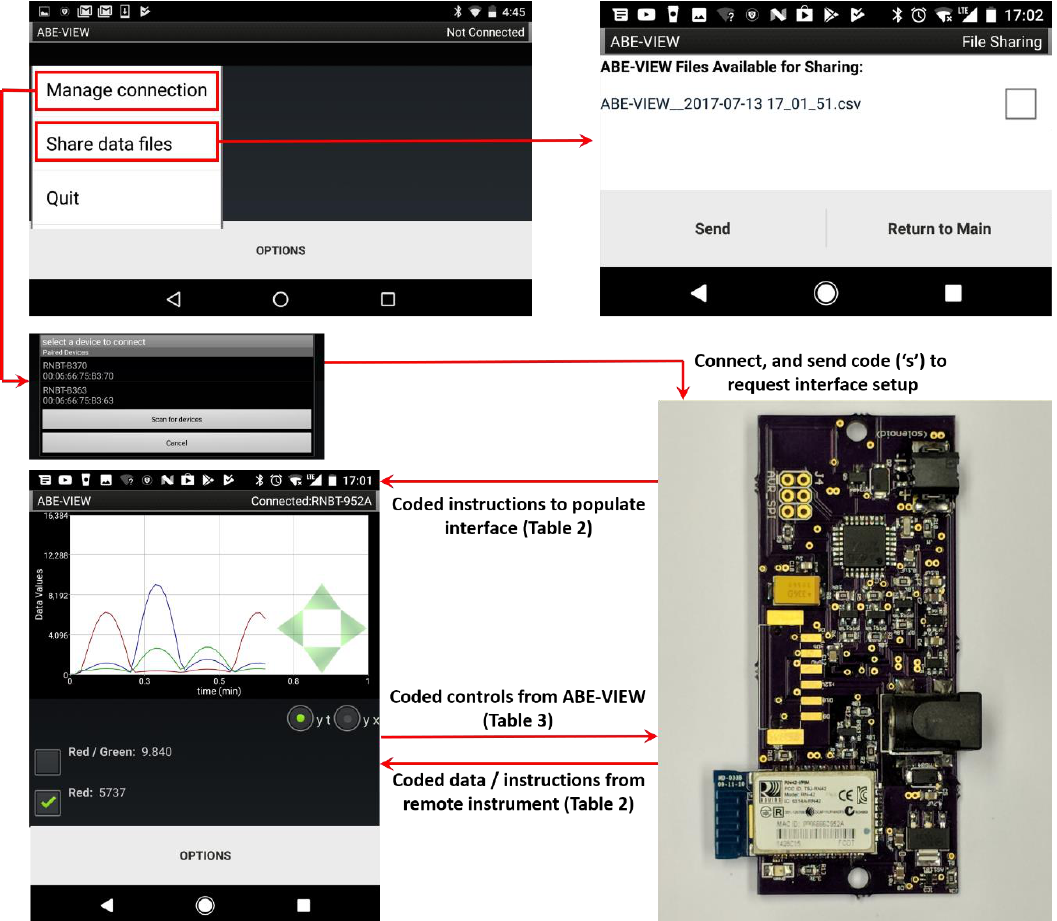
Figure 3. Flowchart for (Bluetooth) communications between ABE-VIEW and remote instrument/device. Upon making a Bluetooth connection with the remote device, ABE-VIEW sends a code ‘s’ that prompts the latter to return coded instructions to populate the interface. Thereafter, user interactions with the GUI result in coded instructions sent to the remote device, and coded data from the remote device are displayed by the app.